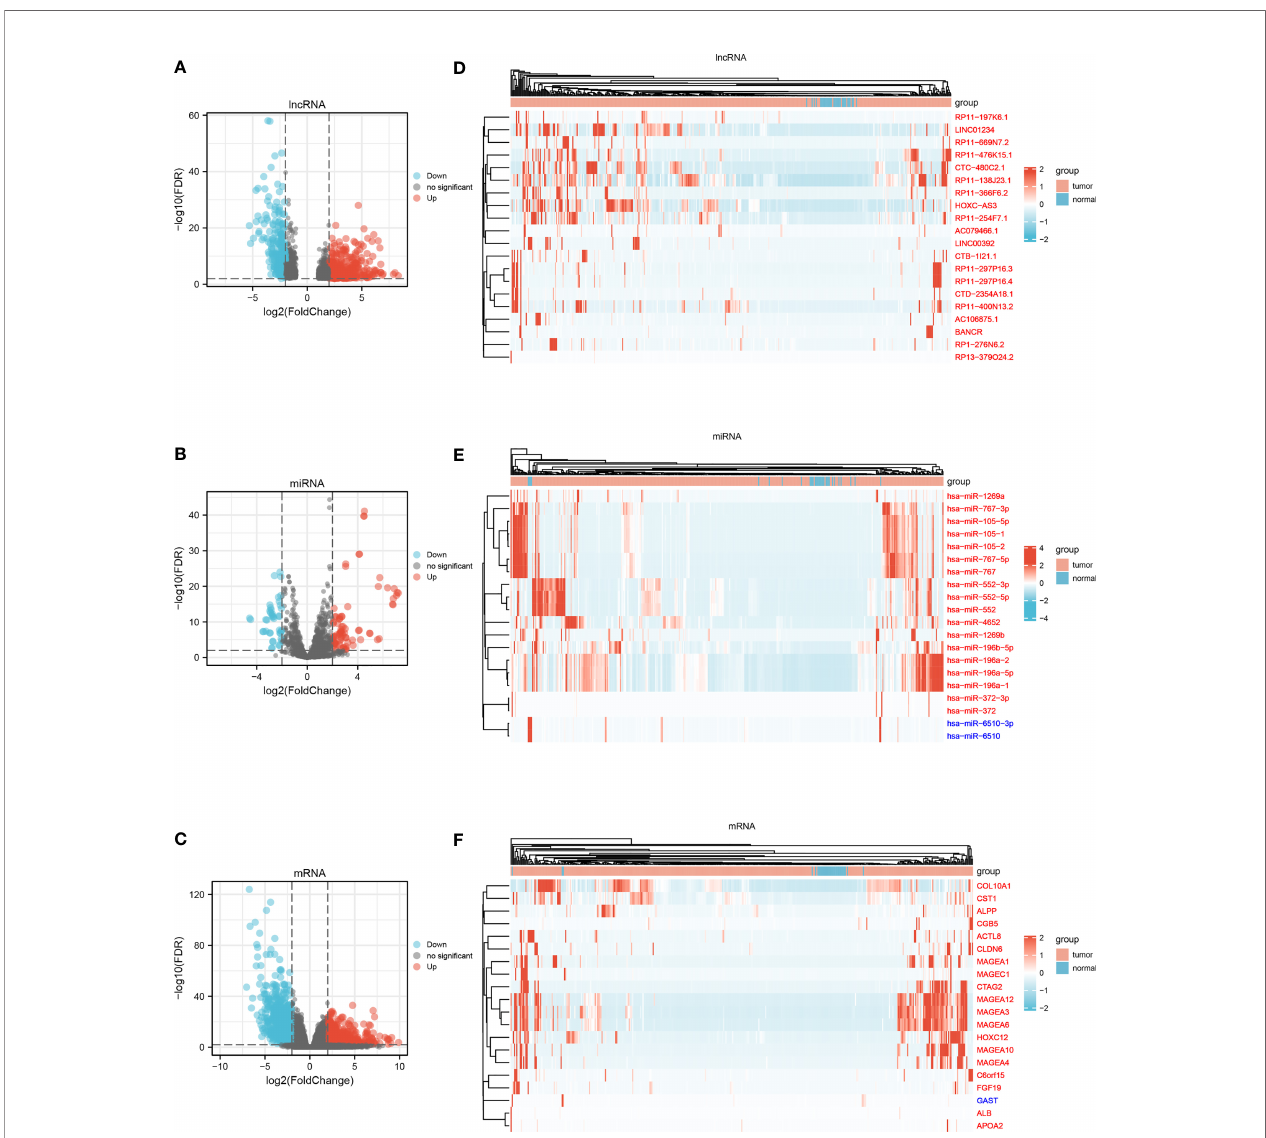
FIGURE 1 | (A) Volcano plot of DElncRNAs. (B) Volcano plot of DEmiRNAs. (C) Volcano plot of DEmRNAs. (D) Heatmap of top 20 variable DElncRNAs. (E) Heatmap of top 20 variable DEmiRNAs. (F) Heatmap of top 20 variable